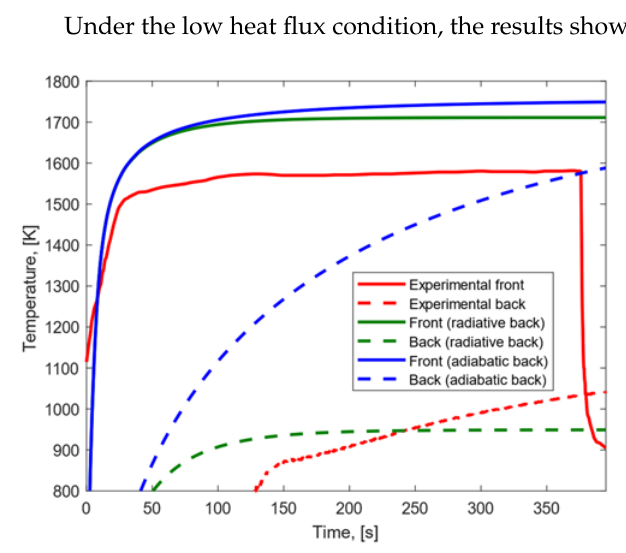
Figure 7. Experimental and modeling temperature profiles for CFRP subjected to low heat